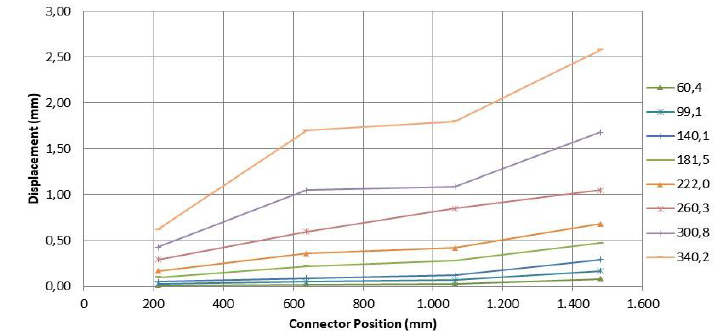
Figure 24. Relative displacement – V2A.